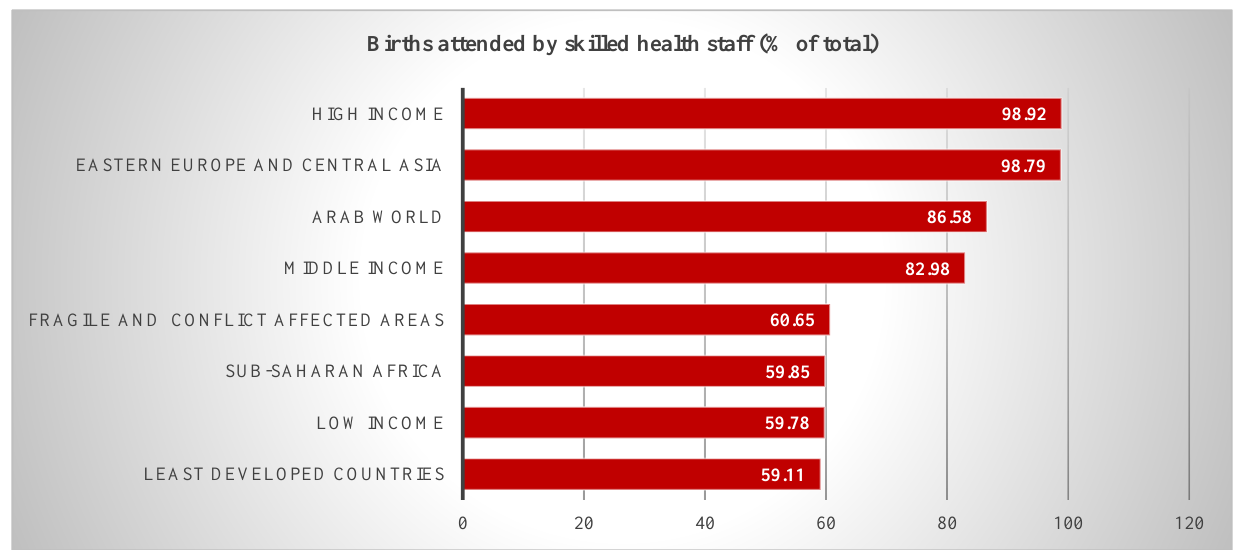
Figure 3. Births attended by skilled health staff (2020). Source: Graph computed using statistics from the World Bank (2022).